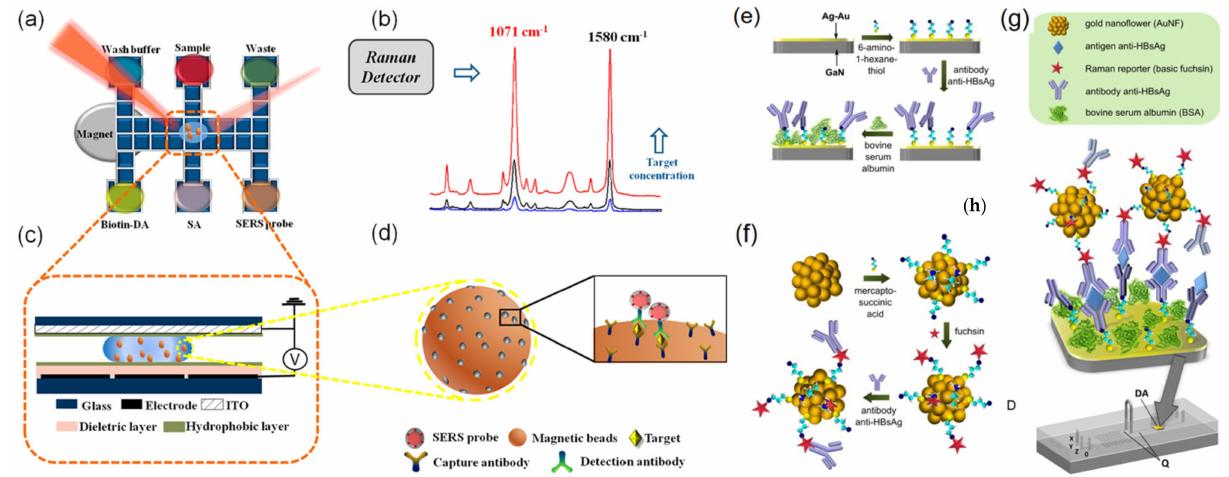
Figure 10. Schematic illustration of SERS-based immunoassay with digital microfluidics. ( a ) Illus- tration of DMF-SERS method and bottom plate of DMF chip. ( b ) Two characteristic Raman peaks of 4-MBA at 1071 and 1580 cm − 1 . ( c ) Side view of DMF chip containing a droplet with magnetic beads. ( d ) Immunocomplex functionalized with SERS tags on magnetic beads. ( e ) Sequential steps for the formation of the SERS-based. ( e ) The capturing substrate preparation, ( f ) the Raman reporter- labeled immuno-Au nanoflowers synthesis, and ( g ) SERS detection of the sandwich interactions, ( h ) schematic illustration showing the integration of a microfluidic device with the SERS-active substrate based on Au–Ag coated GaN surface. DA, detection area chamber with GaN/Au–Ag SERS substrate. ( a – d ) Reproduced with permission of Ref. [85], Copyright 2018, American Chemical Society. ( e – h ) Reproduced with permission of Ref. [86], Copyright 2014, Elsevier